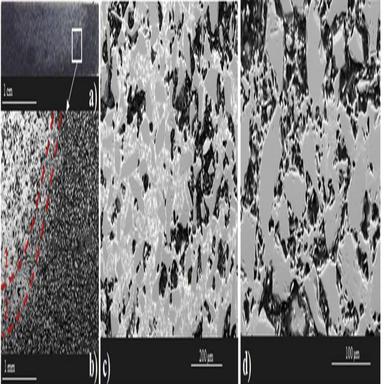
BSE images of SiCp-C preform microstructure infiltrated with liquid Si-Ir eutectic alloy at T = 1250 °C. a) Global microstructure of infiltrated area and b) detail of the infiltration front at higher magnification.